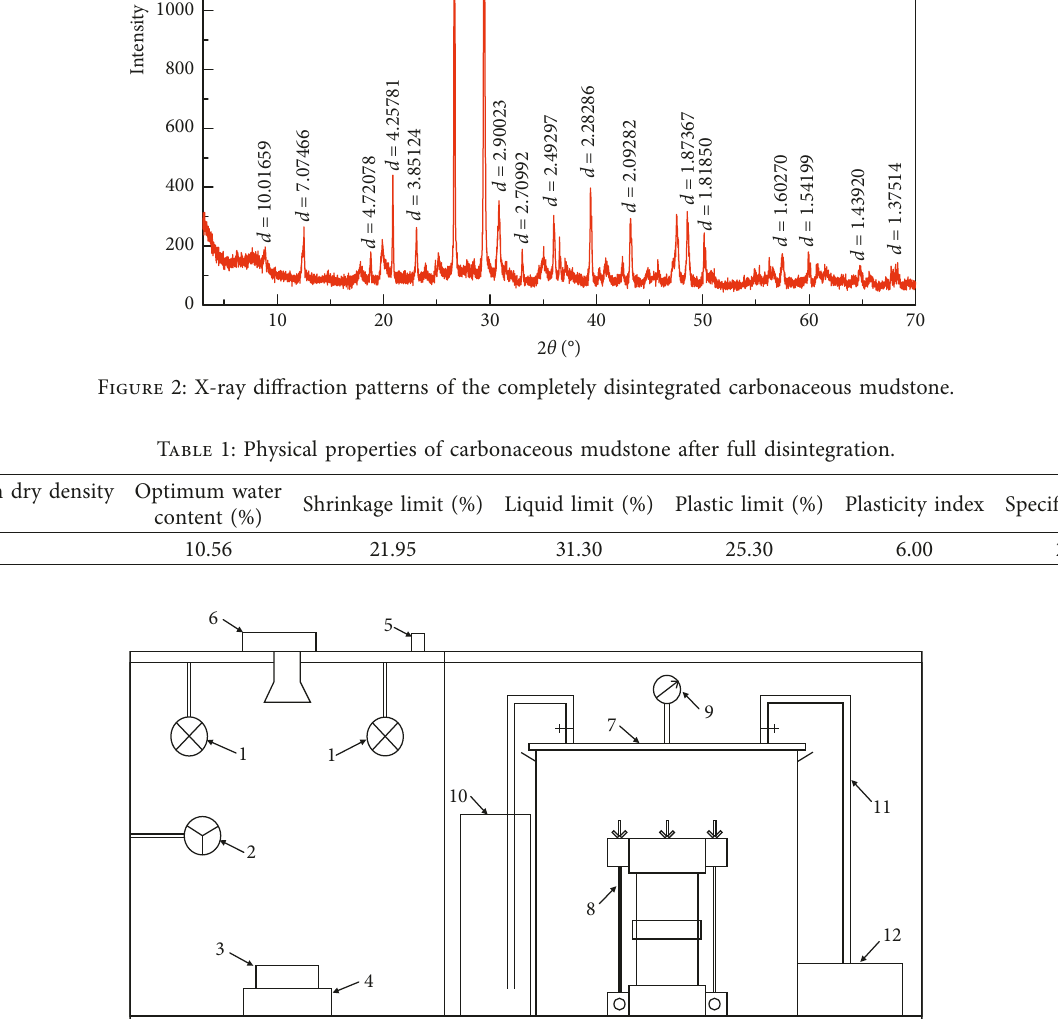
Figure 3: Sketch of the new test instrument. 1: heat lamp for drying the sample; 2: fan for accelerating the air convection; 3: sample;